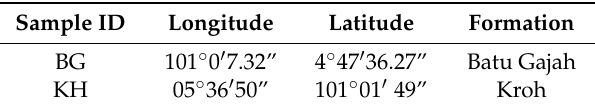
Table 1. Sample ID and